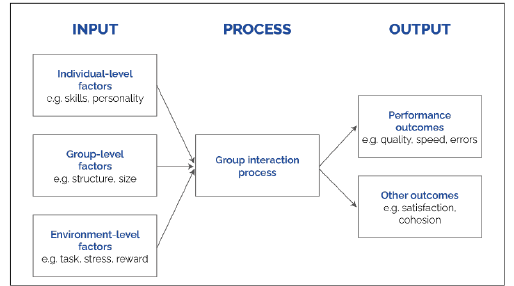
Figure 1. McGrath’s (1964) input-process-output model